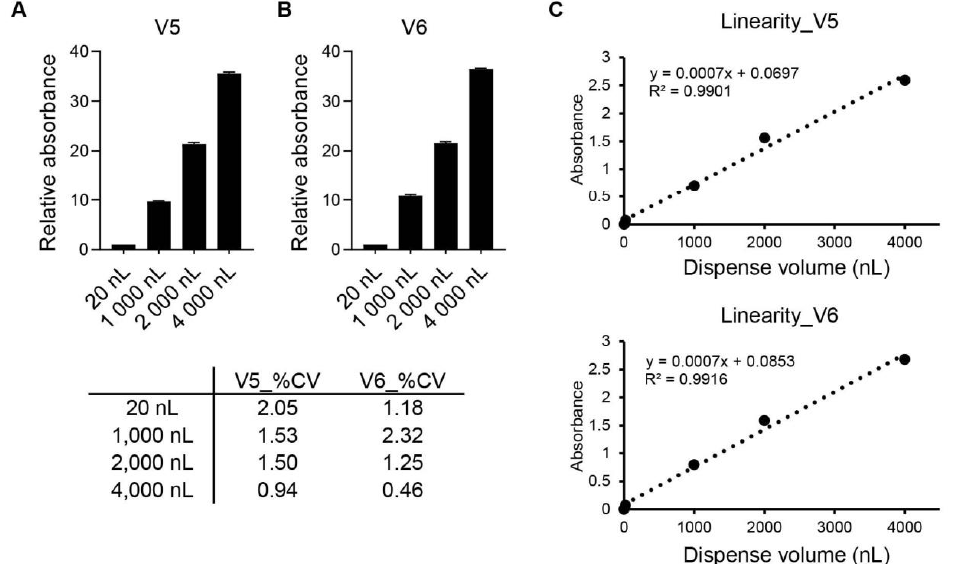
Figure 2. Dispense accuracy and precision of determined volumes. ( A , B ) 70% BME with Orange G dye was dispensed with indicated volume into 20 wells of 384-well plates using ASFA SPOTTERs V5 ( A ) and V6 ( B ). The absorbance was confirmed at 450 nm for dispensing accuracy and precision. ( C ) The absorbance mean values at each volume were plotted for linear regression. To determine the dead volume (additional required volume, including a pre-shot and flushing shot) in conditions with 0.5% Alginate, 50% Matrigel, and 70% BME, the 72 mi- croliters of viscous solution were dispensed with 48 spots into the well plate (1500 nano- liters per spot) using ASFA SPOTTER V6. Consistent dispensing of biomaterials up to 44 spots for BME and Matrigel and 47 spots for Alginate was achieved, as demonstrated by absorbance. It demonstrates that 6 microliters for BME and Matrigel and 1.5 microliters for Alginate are additionally required for dispensing biosamples with a similar scale, with